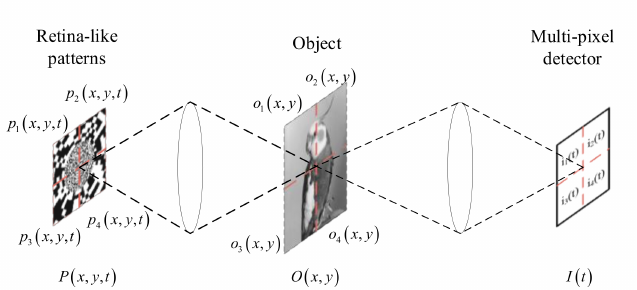
Figure 18. Measurement principle of the parallel retina-like computational